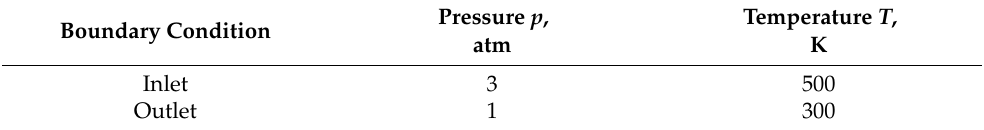
Pressure p , Temperature T , atm K